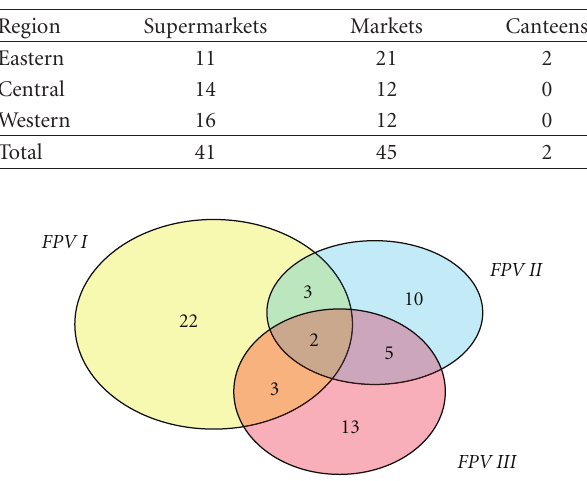
Figure 2: Distribution of pyoverdine receptor genes detected by PCR in P. aeruginosa isolates in this